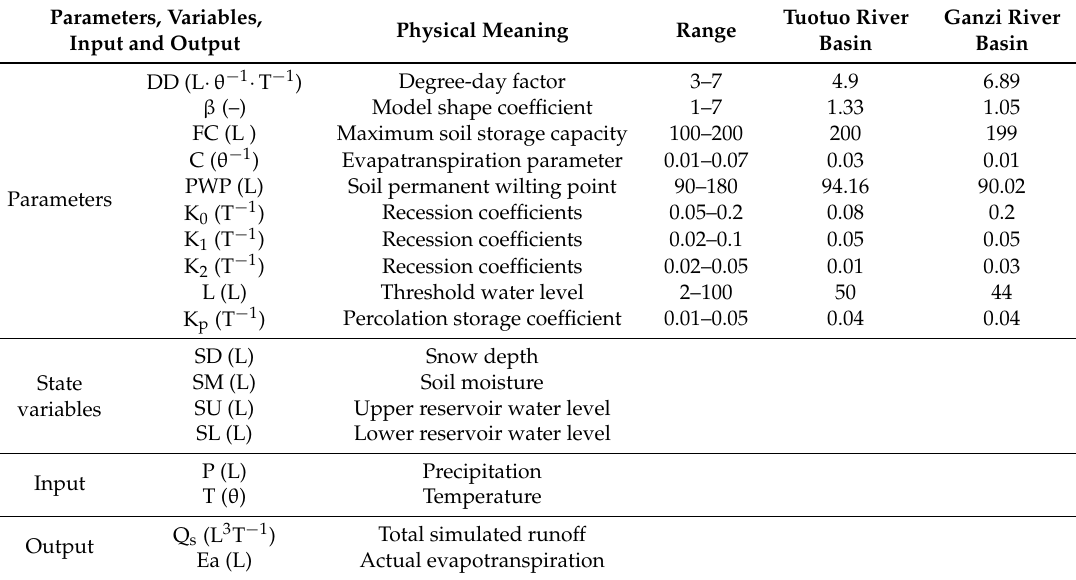
Table 1. Parameters, state variables, inputs and outputs (with ranges) for the HBV